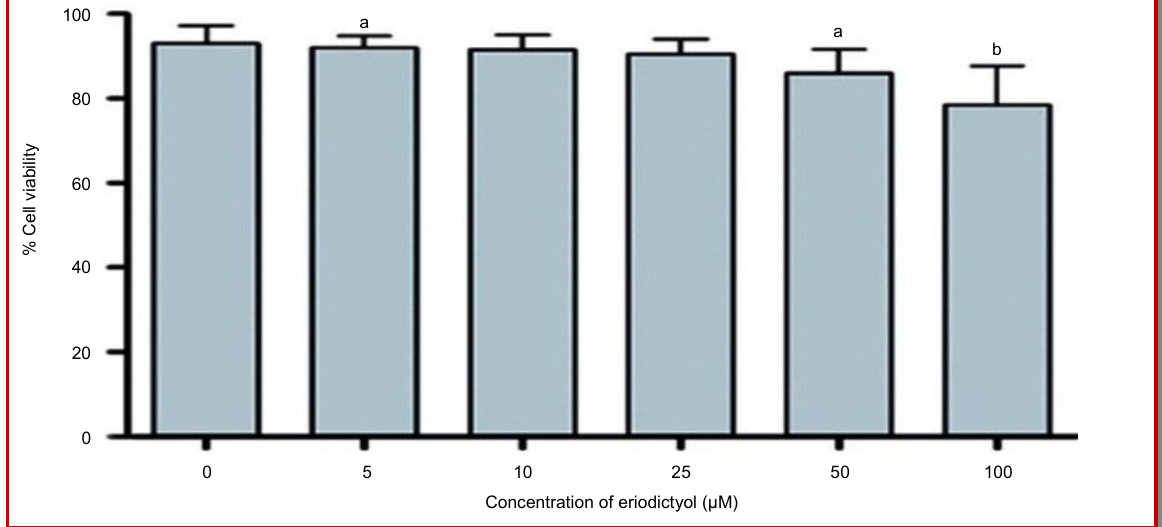
Figure 3: Cytotoxic effect of eriodictyol in AML12 normal liver hepatocyte cell line. Data are shown as mean ± SD of three inde- pendent experiments. a p<0.05, b p<0.01, vs 0 µM (control). The normal cells showed less susceptibility towards eriodictyol as compared to the cancer cells